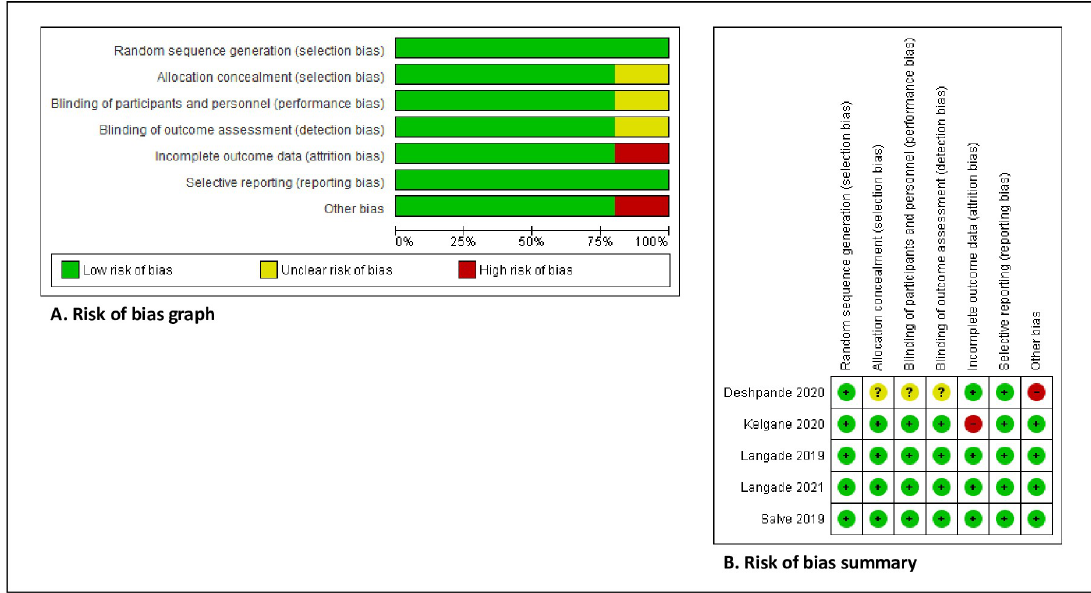
Fig 2. (A) Risk of bias graph: Review authors’judgements about each risk of bias item presented as percentages across all included studies, (B) Risk of bias summary: Review authors’ judgements about each risk of bias item for each included